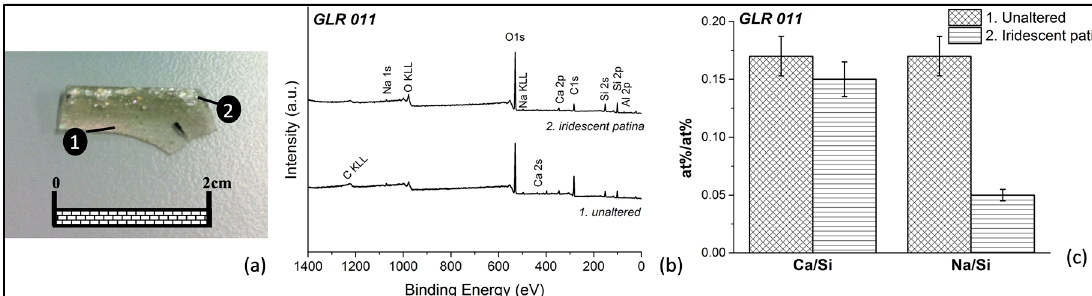
Figure 8. ( a ) The analyzed areas selected on sample GLR011 are shown in the photograph; ( b ) The X-ray photoelectron survey spectra acquired on the two different areas with the monochromatic Al K α X-ray source using a beam of 400µm are compared and ( c ) the chemical composition provided as surface cations/silicon ratios is presented for the same analysis points.